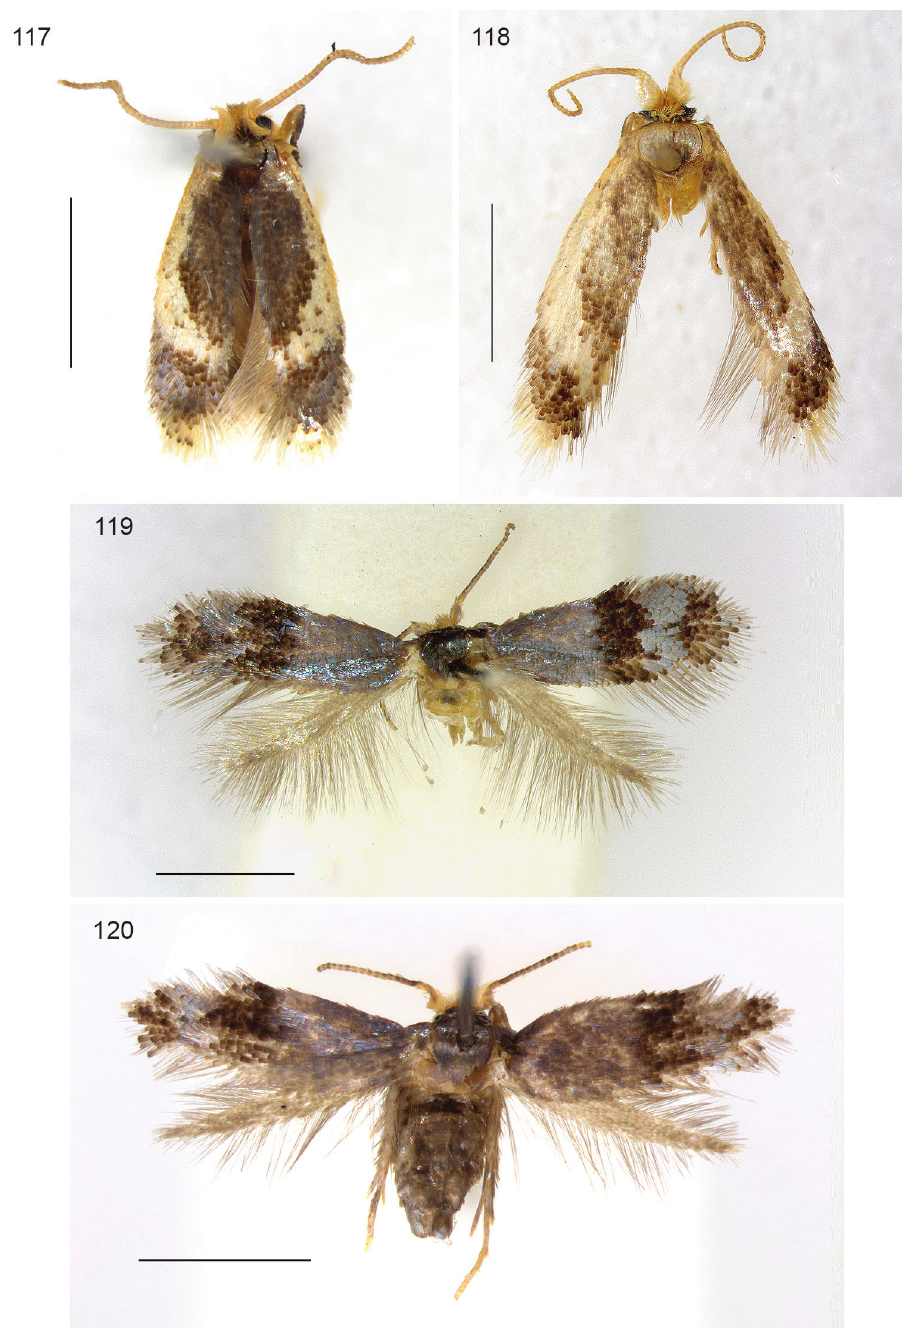
Figures 117–120. Hesperolyra gen. n., adult habitus. 117 H. diskusi , male paratype, RMNH.INS.24501 118 H. diskusi , female paratype, BMNH(E)1625477 119 H. saopaulensis , female holotype 120 H. sao- paulensis , female RMNH.INS.24505. Scale bars: 1